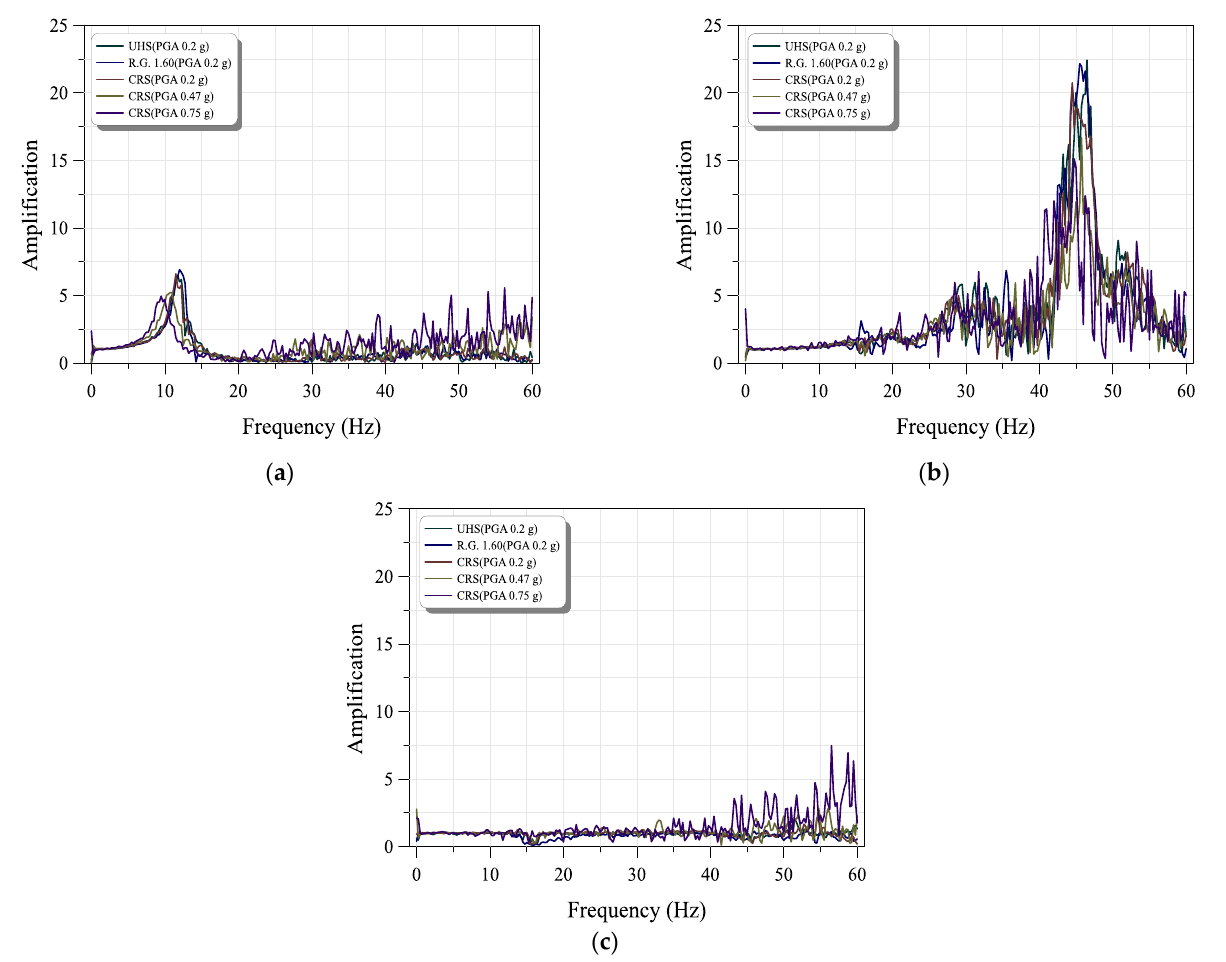
Figure 13. Comparison of amplification based on input motion at A9 (relay): ( a ) side to side, ( b ) front to back, and ( c ) vertical. Table 6. Amplification results of in-cabinet response based on input motion.